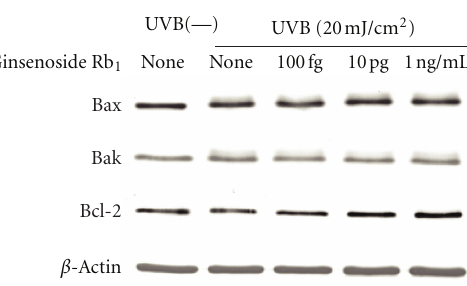
Figure 12: E ff ects of ginsenoside Rb 1 on Bax, Bak, and Bcl-2 expression levels in UVB-irradiated human primary keratinocytes [31]. Human keratinocytes (3 × 10 5 cells) were seeded in a 100- mm culture dish and cultured in KG-2 medium for 48 h. The cells were irradiated with UVB (20mJ/cm 2 ) and treated with the indicated amounts of ginsenoside Rb 1 for 24 h in KB-2 medium. After being washed with phosphate-bu ff ered saline (PBS, pH 7.0), the cells were treated with lysed bu ff er. The supernatant obtained by centrifugation was subjected to a western blot analysis with anti- Bcl-2, anti-Bax, anti-Bak, and anti- β -actin